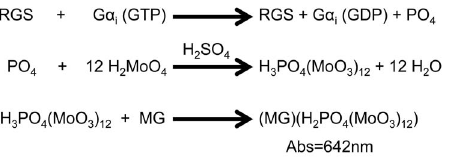
Figure 1. Scheme of Malachite Green Assay. RGS protein interacts with G a i and induces the hydrolysis of GTP to GDP, releasing free phosphate. In the presence of acid, molybdate releases water and complexes with the free phosphate. Lastly, the phosphomolybdate complex associates with the malachite green to produce a strong absorbance peak at 642 nm.